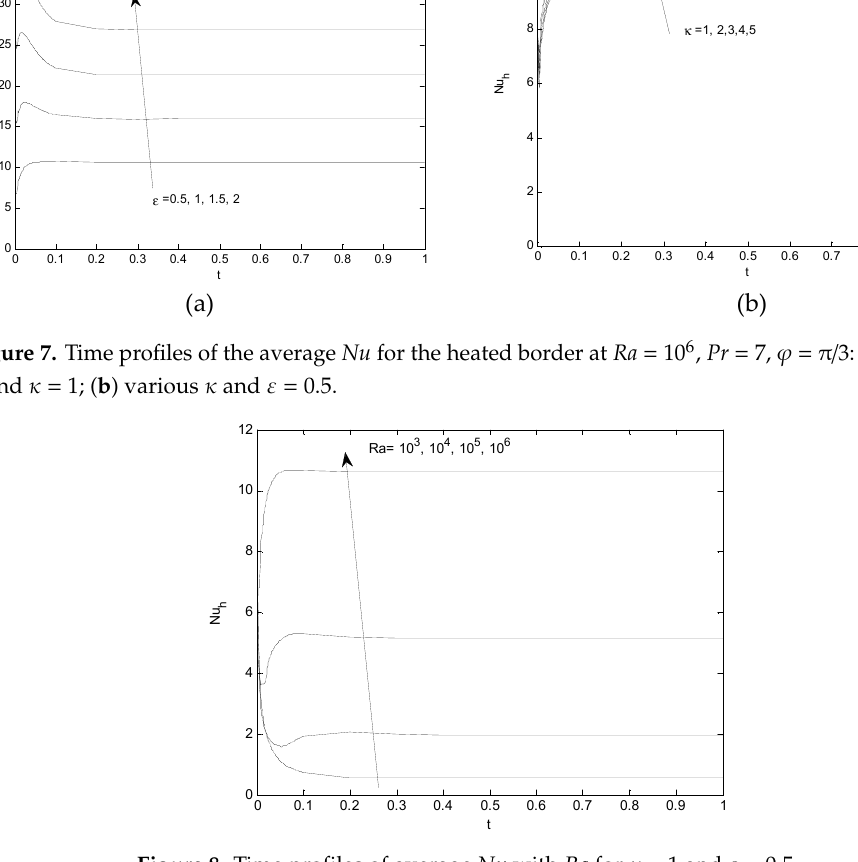
Figure 8. Time profiles of average Nu with Ra for κ = 1 and ε = 0.5.